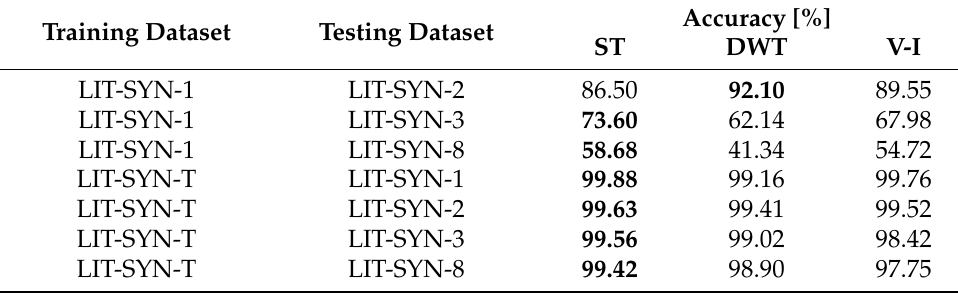
Table 4. Macro Accuracy for different subsets of